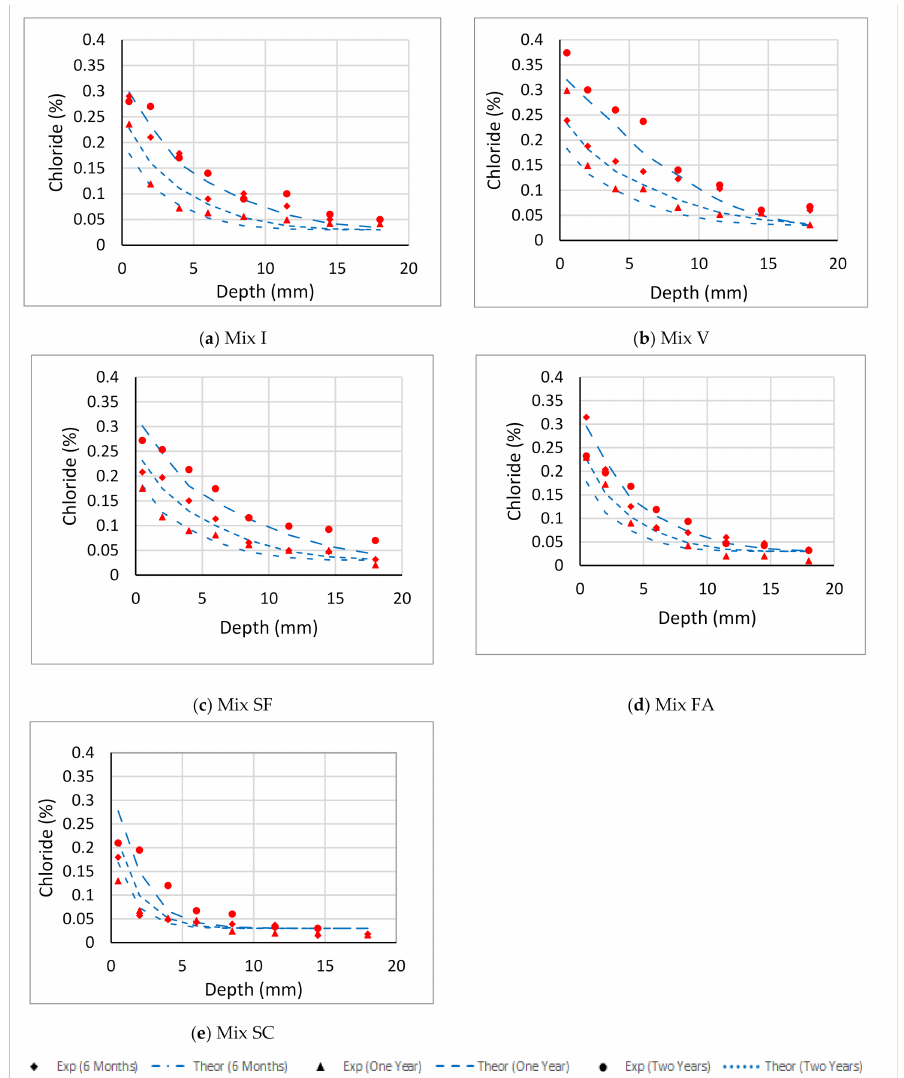
Figure 6. Chloride profiles for mixes in the tidal zone using the experimental binding results. ( a ) concrete with 100% ordinary Portland cement (OPC), ( b ) concrete with 100% type V cement (Sulfate resistance), ( c ) concrete with 6% silica fumes and 94% OPC, ( d ) concrete with 25% fly ash and 75% OPC, ( e ) concrete with 70% slag cement and 30%